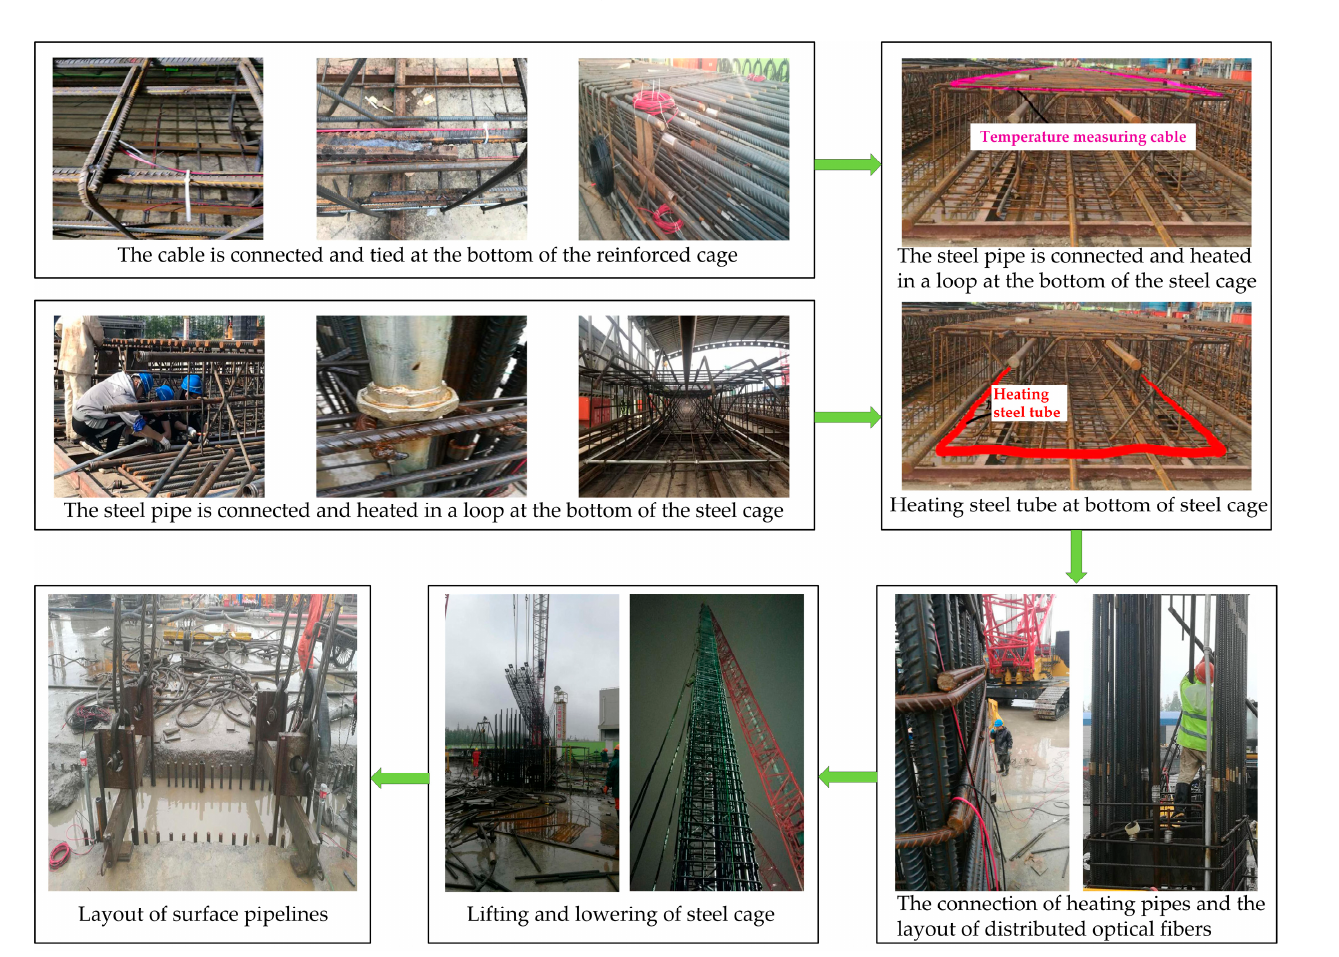
Figure 27. Field layout of temperature measuring optical fibers.